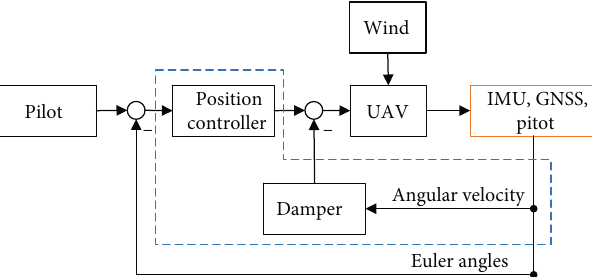
Figure 7: Structure of the closed control loop system. The IMU is shown on the right side in orange and measures the Euler angles every 30ms. The pilot commands the set value with a commercial remote. The di ff erence between the set value and the actual value is o ff ered by the controller, which calculates itself a control signal to get the airframe to the desired position. The damper damps the own movement of the airframe, and the complete control system is also sensitive to disturbances such as wind gusts. The internal control algorithm is called “ basic controller ” and is framed in blue. Table 1: Parameters of the controller by numerical optimization. Parameter K